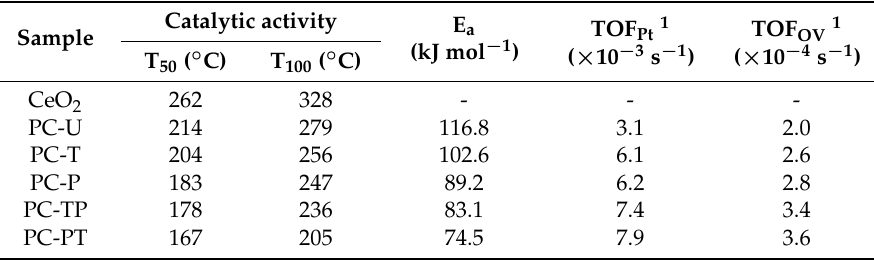
Table 1. Catalytic performances of various samples.